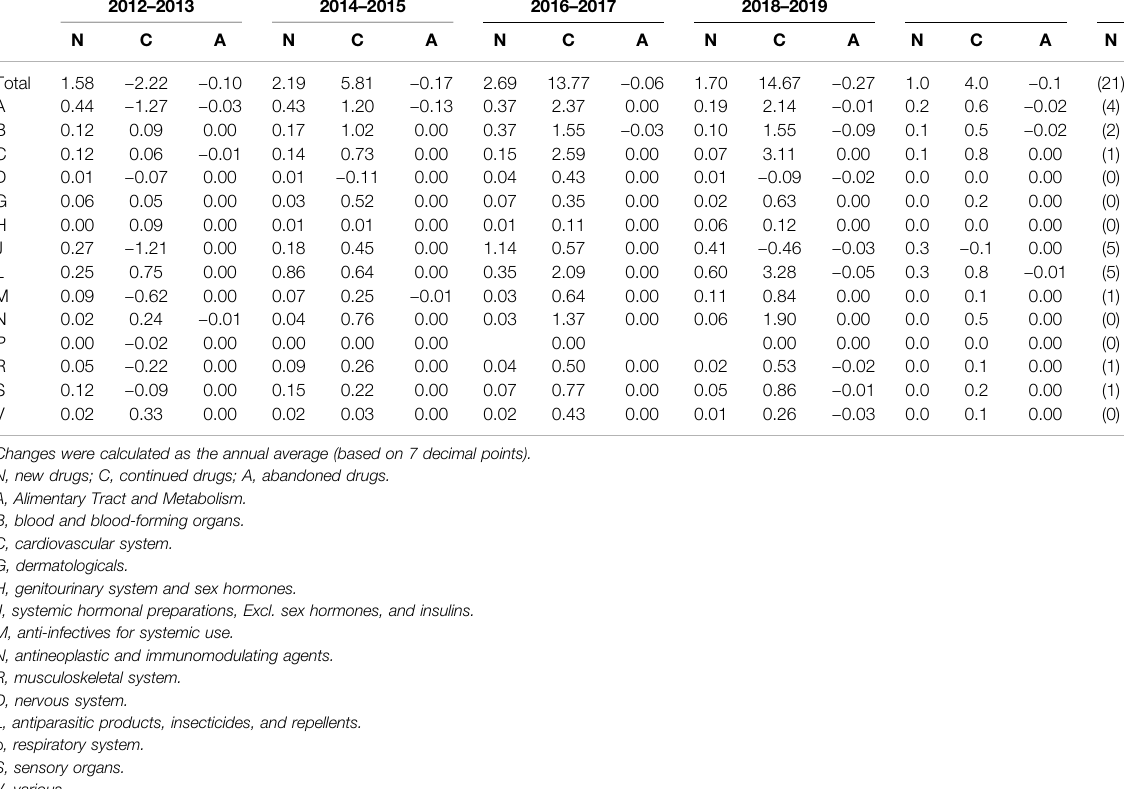
Changes were calculated as the annual average.